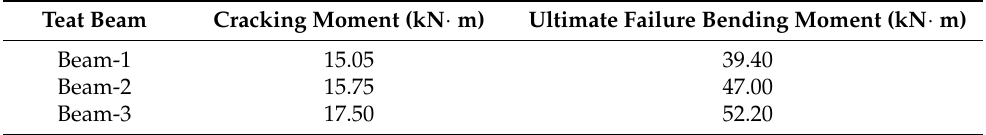
Table 3. Measured values of the cracking moment and ultimate failure bending moment. Teat